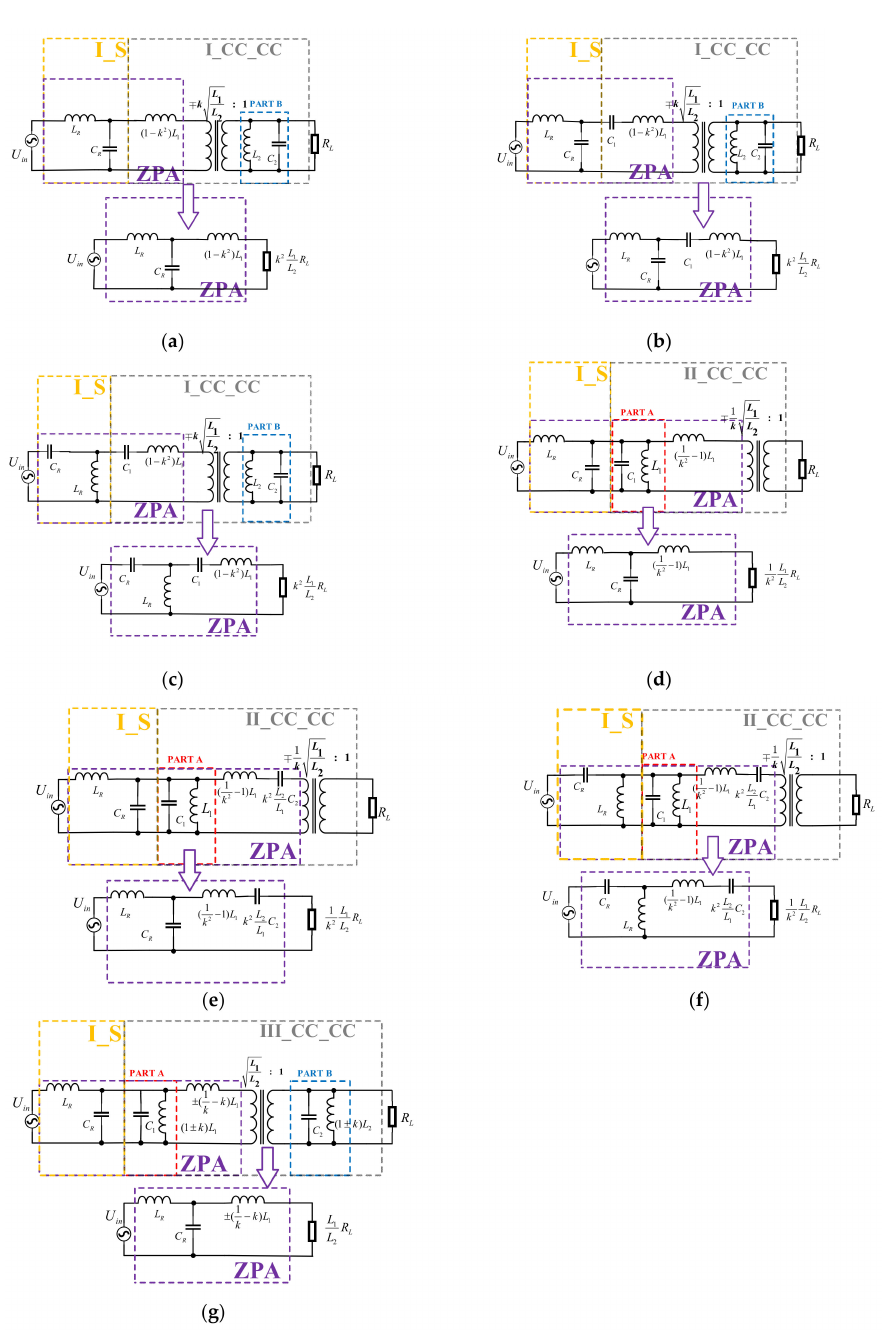
Figure 24. The S_CC_CC compensation topologies: ( a ) LCL/P [21,22,24–26]; ( b ) LCC/P [15,21,25]; ( c ) CLC/P [21]; ( d ) LC; ( e ) LC/S [27]; ( f ) CLC/S; and ( g ) LCL/P